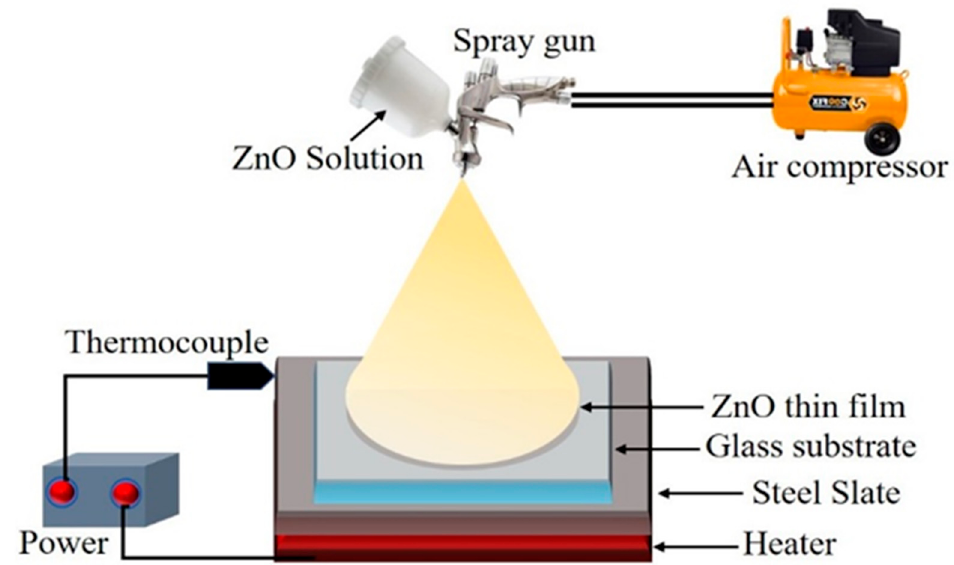
Figure 10. Schematic diagram of the spray pyrolysis method.